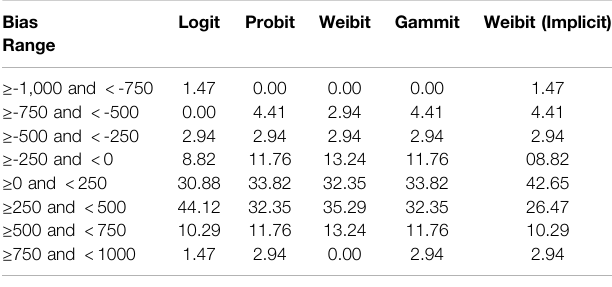
TABLE 7 | Bias frequencies